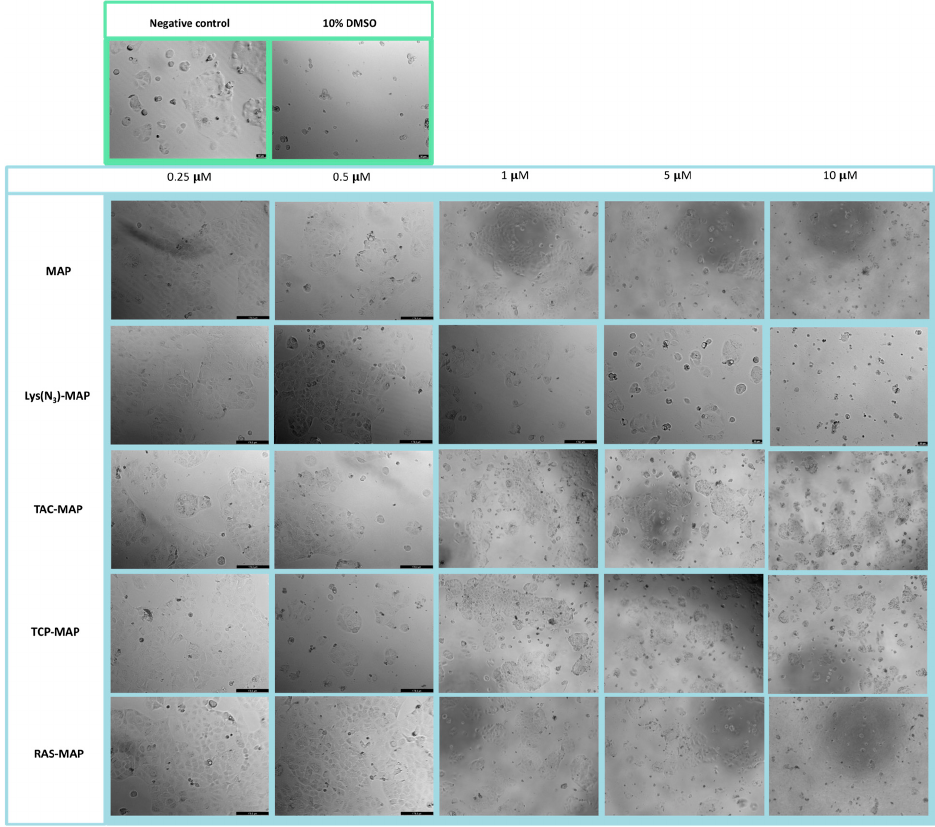
Figure 2. Microscope cellular visualization through Lionheart FX and Leica DFC350 FX of treatment with negative control (ultra ‐ purified H 2 O), positive control (10% DMSO), free peptides, and conjugates on Caco ‐ 2 cell line at concentrations of 0.25, 0.5, 1, 5, and 10 μ M respectively.